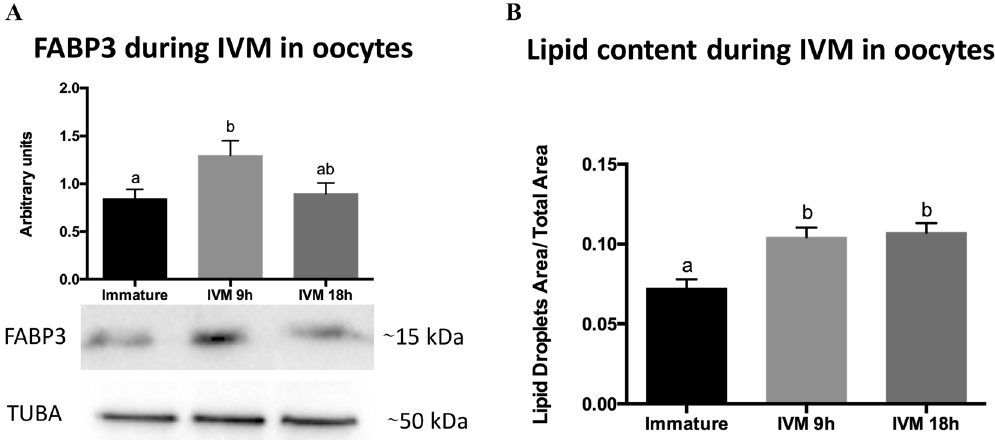
Figure 7. Fatty acid binding protein 3 (FABP3) protein levels and lipid content in oocytes from immature cumulus-oocytes complexes (COCs) and COCs in vitro -matured for 9 and 18 h. ( A ) FABP3 protein quantification in oocytes was performed by western blot analysis using x-Tubulin (TUBA) as the normalizer. The full western blot image is shown in Supplementary Fig. S2c. ( B ) Lipid quantification in oocytes. The values for lipid content represent the ratio of the area of lipid droplets to the total oocyte area. Letters above bars in the same graph indicate significant difference ( P < 0.05). Values are represented as mean ± standard error of the